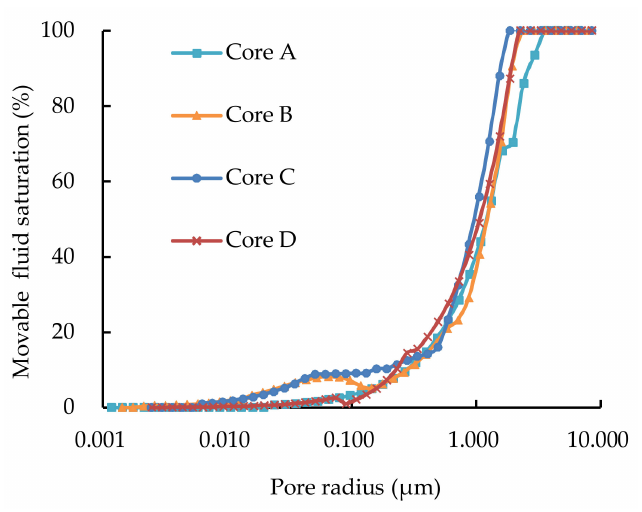
Figure 4. Movable fluid saturations in the different pore cores.